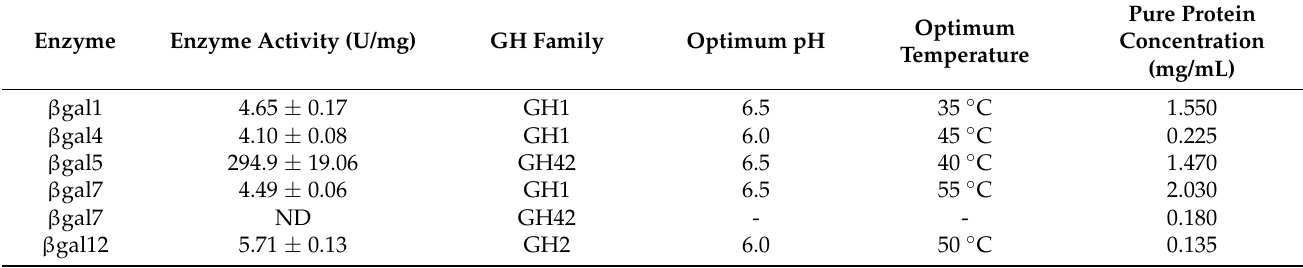
Table 3. Specific activity on 2-nitrophenyl- β -D-galactopyranoside (ONPG) and β -galactosidases properties. Data were obtained from biological replicates ( n = 3). MM, molecular mass. ND, not detected.